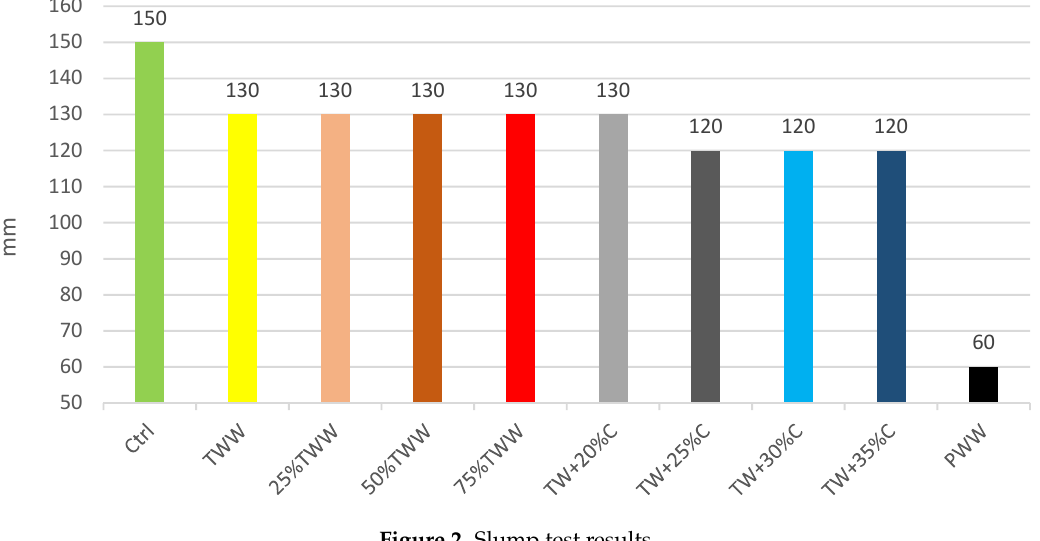
Figure 2. Slump test results.